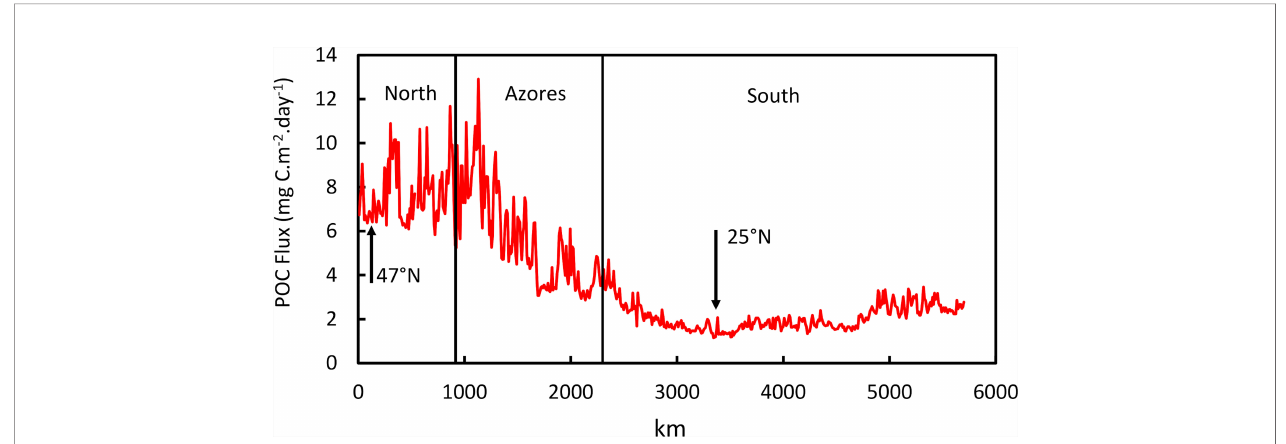
FIGURE 6 | Mean POC Flux during the years 2002-2020 along the axis of the MAR from 48°N (0 km) to 10°N across the three latitudinal strata, North, Azores and South. Arrows at 47°N and 25°N are locations of transects in shown in Figure 4